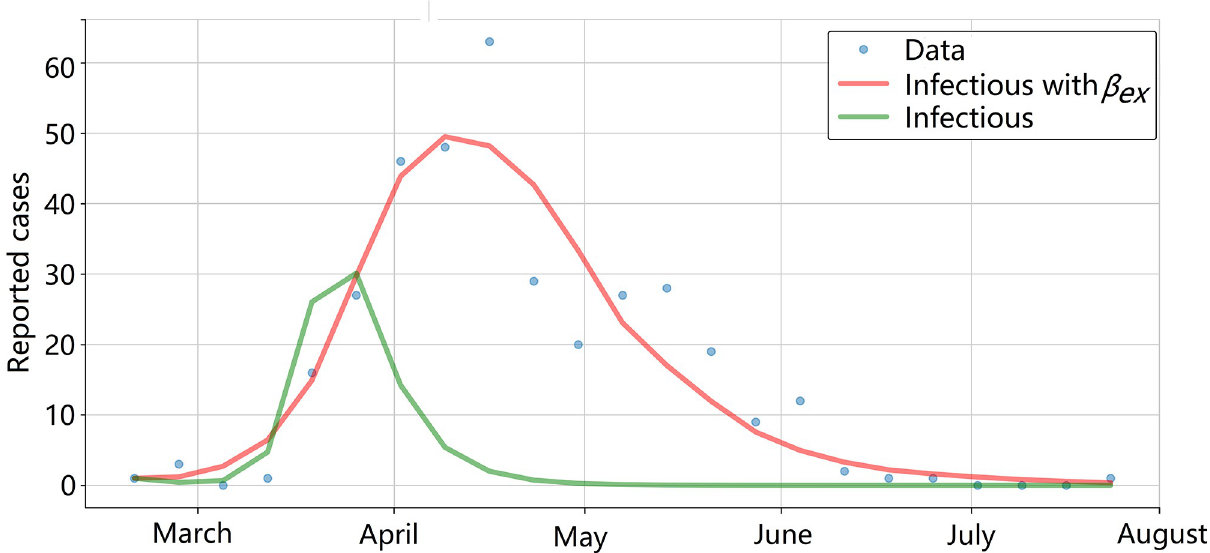
Fig 6. SIR-SI model with the Gaussian exogenous variable and climatic conditions adjusted for 2017. The adjusted analysis without the exogenous variable is in green, and the adjusted analysis with model 4 is in red.